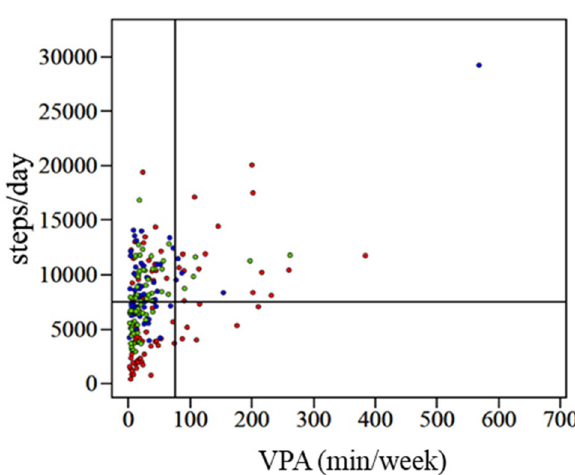
Figure 4. Scatterplots depicting the relationship between vigorous physical activity (VPA) (per week) and step counts of all participants. The vertical line indicates the VPA guidelines (≥ 75 min/week) recommended by the World Health Organization, and the horizontal line indicates the step count recommendation for older women (≥ 7500 steps/day), as reported by Lee et al. 25 . (cid:1749) : Student group; (cid:1749) : Standing worker group; (cid:1749) : Sitting worker group. Upper right: first quadrant; upper left: second quadrant; lower left: third quadrant; lower right: fourth